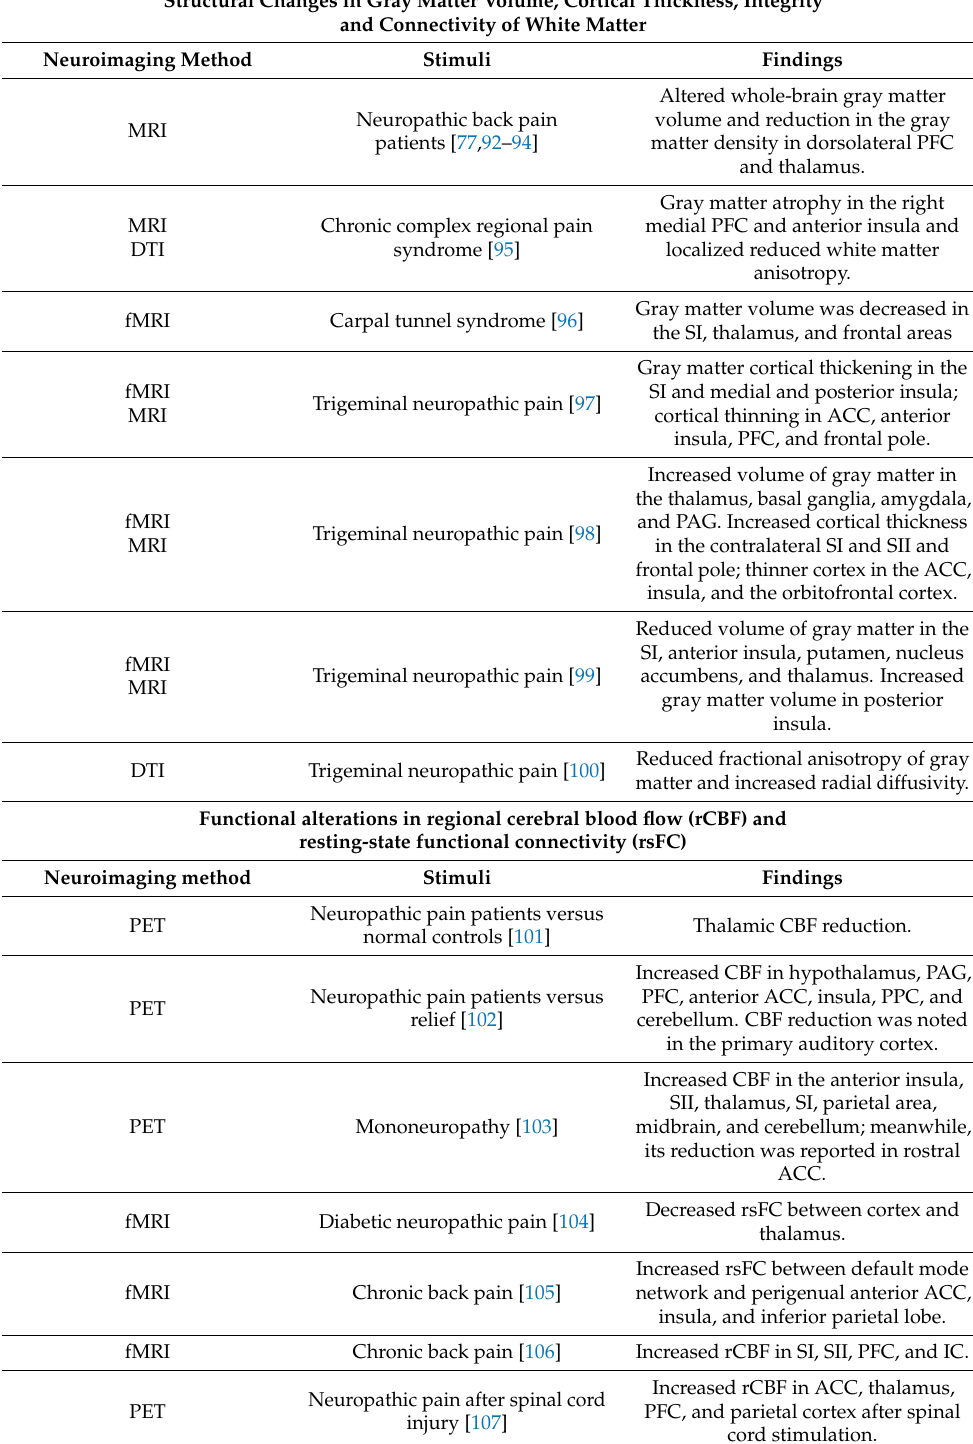
Table 1. A summary of the neuroimaging-based biomarkers in chronic neuropathic pain. Structural Changes in Gray Matter Volume, Cortical Thickness, Integrity and Connectivity of White Matter Neuroimaging